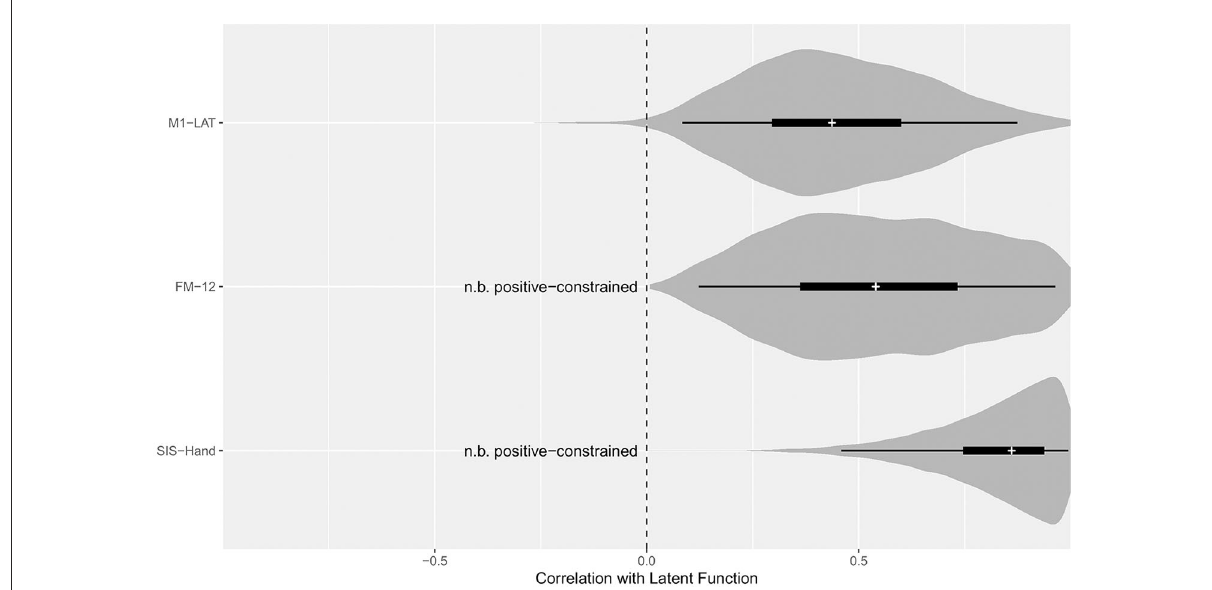
FIGURE5 Posterior distributions for the correlation between the latent function trait and each sub-trait. Violin density functions depict the smoothed posterior density (with tail-transparency as per, Helske and Vihola, 2021), thin lines covering the CrI 95 % , thick lines covering the CrI 50 % , and medians indicated by the white cross. The SEM model constrained the potential relationship between FM-12 and latent function, as well as SIS-Hand and latent function, to be positive; while the relationship between M1-LAT and latent function was free to vary from − 1 (i.e., a perfect negative correlation between M1-LAT and latent function) to + 1 (i.e., a perfect positive correlation between M1-LAT and latent function).